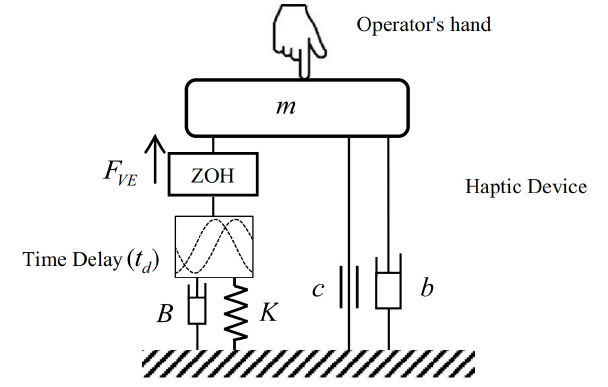
Figure 1. Structure diagram of a haptic